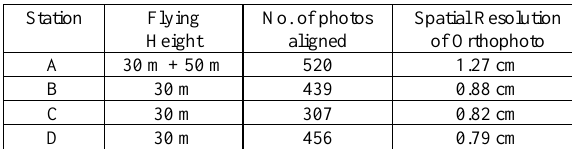
Table 1. Summary of UAV Processing